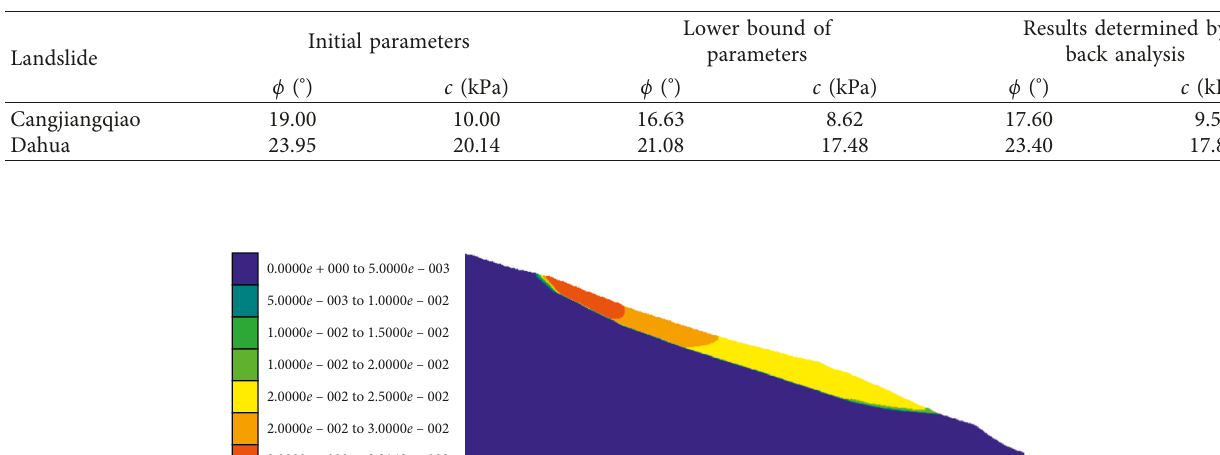
Table 7: Back analysis results for strength parameters.